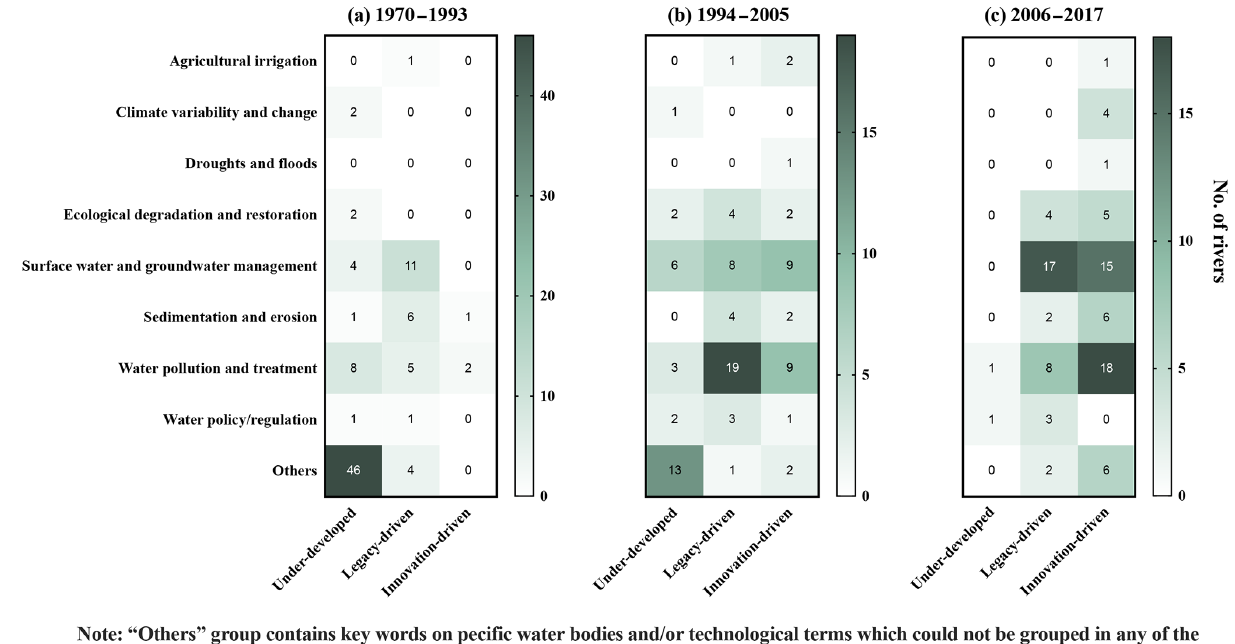
Figure 5. Mapping of the river basins situated in the knowledge spectrum to their issues of focus during (a) 1970–1993, (b) 1994–2005, and (c)